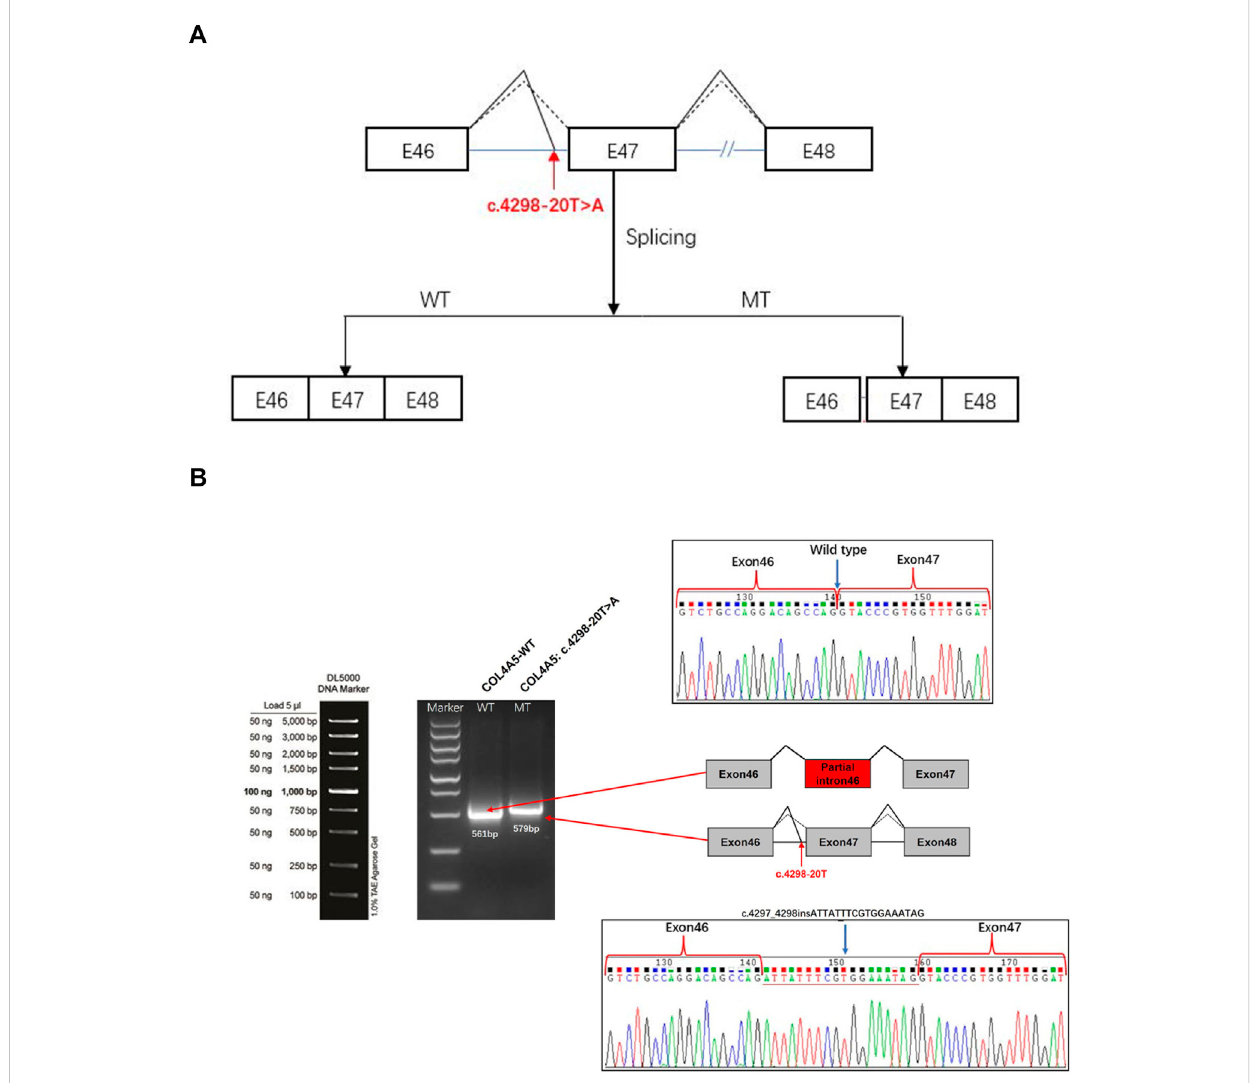
FIGURE 3 COL4A5 gene constructs for splicing pattern investing of the patient. (A) Splicing schematic diagram. The Bioinformatics software dbscSNV and SpliceAI predicted that the mutation might lead to a splicing variation of exon 46 of the COL4A5 gene. (B) COL4A5 gene c. 4298 – 20T > A splicing pattern Minigene veri fi cation experiment. COL4A5 -WT and COL4A5 -MT were transiently introduced into 293T cells. After the RNA was extracted, the splicing products were analyzed by RT-PCR. Lower bands represent correct splicing, while higher bands represent the COL4A5 inserted 18 nucleotides in intron